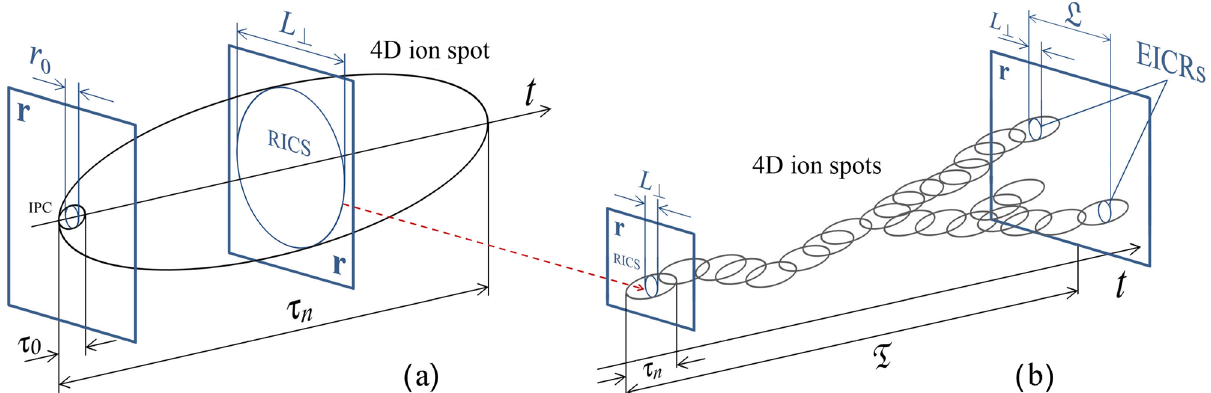
Figure 5. Schematic representation of ( a ) the formation of a residual ion concentration spot (RICS) and ( b ) evolution of overlapping RICSs into elevated ionic conductivity regions